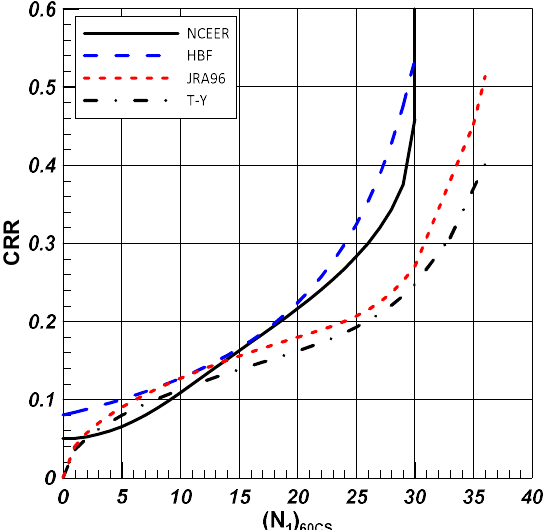
Figure 2. Liquefaction triggering curves of four simplified liquefaction analysis procedures. The primary parameters of the Finn model with Byrne formulation are listed in Table